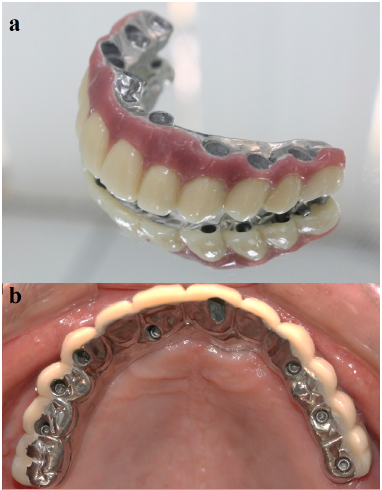
Figure 1. ( a ) Example of experimental prosthesis milled in metal. For this design, only the buccal face receives the esthetic covering. ( b ) An example of occlusal view of the experimental design. This picture has been used as base for the modeling used in the Finite Element Analysis (FEA).